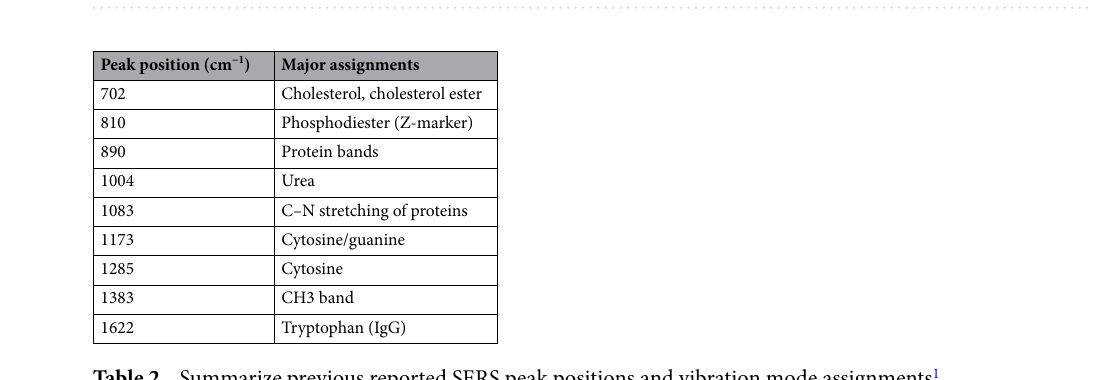
Figure 1. The SERS spectra of patients’ urine samples. The main SERS peaks (vibrational assignments) of tested urine samples were assigned to 1383, 1285, 1004, and 702 cm −1 , which represent for CH3, urea, cholesterol, and cytosine band.